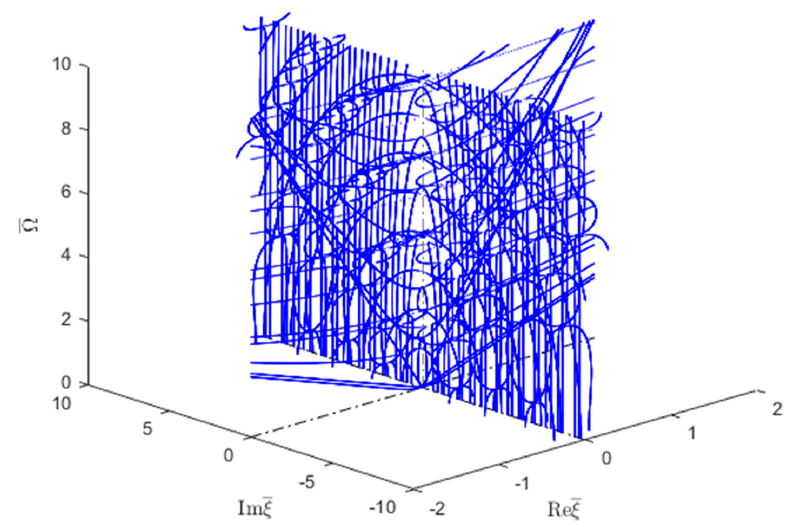
Figure 12. wavenumber solution of GWs for unidirectional CFRP composite.